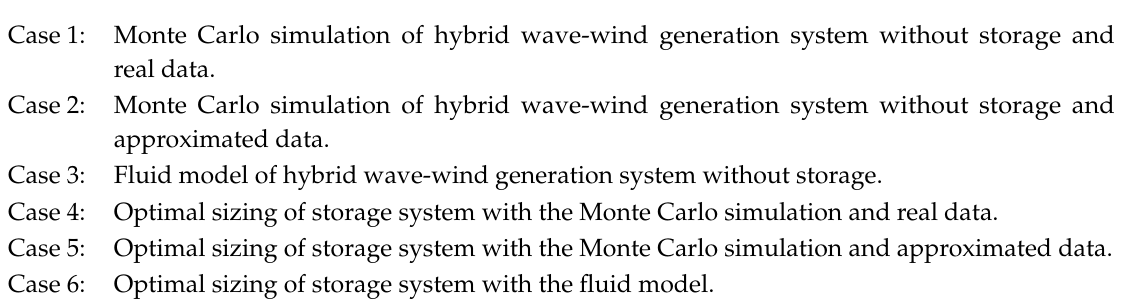
Figure 10. Histogram and pdf of storage input with: ( a ) Real data; and ( b ) Normal distributions.